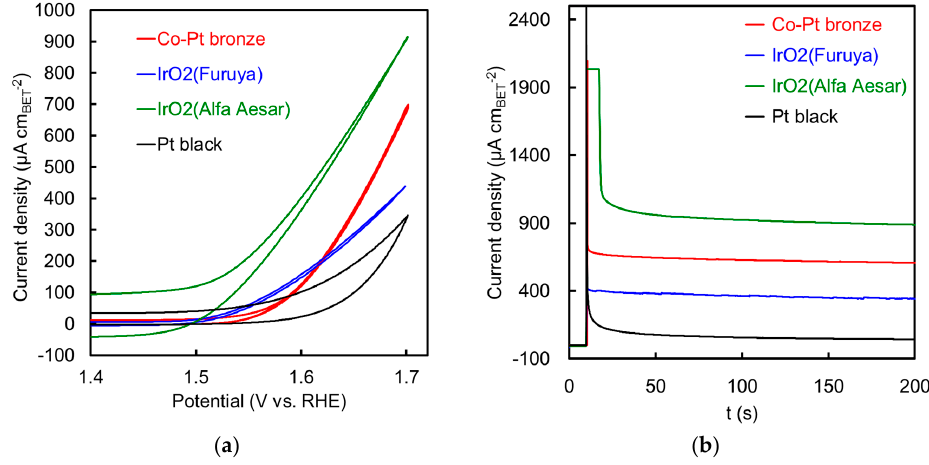
Figure 5. OER activity measurement results, ( a ) potential sweep and ( b ) Potential hold at 1.7 V (vs. RHE). Table 1. Specifications of tested OER catalysts. Table 1. Specifications of tested OER